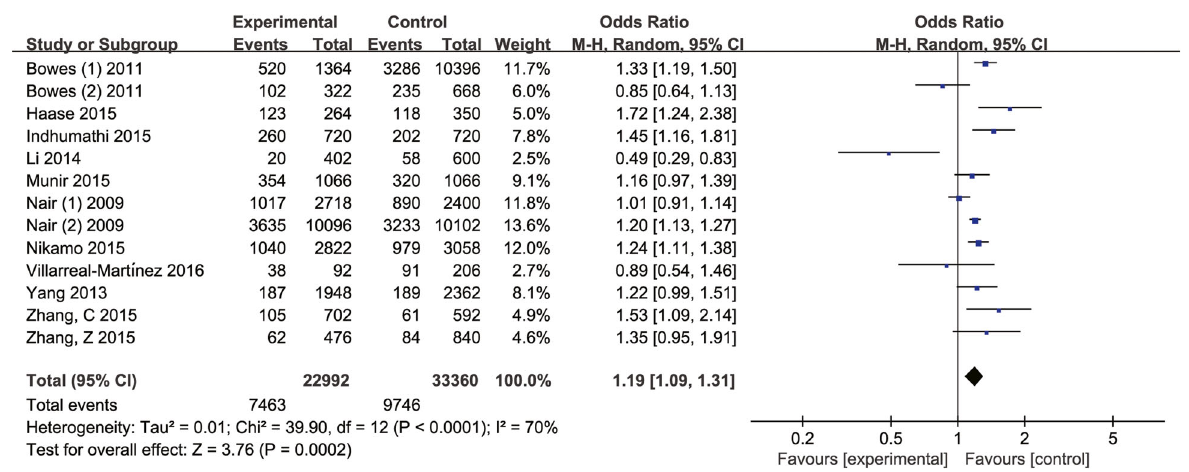
Fig. 3 Forest plot of rs610604 in TNFAIP3 gene and risk of psoriasis